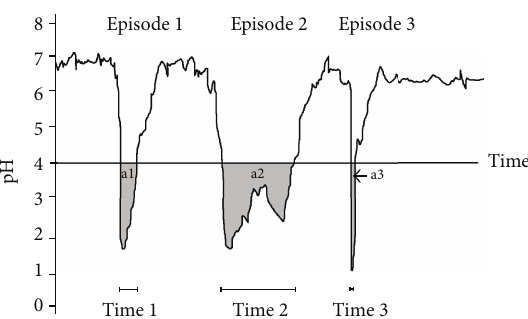
F 1: ree different parameters used for pH-monitoring data analysis are compared. ere are 3 re�ux episodes displayed (Episode 1, Episode 2, andEpisode 3). Acidexposure timeis thesum of Time 1, Time 2, and Time 3. Re�ux area is the sum of calculated a1, a2, and a3 areas.